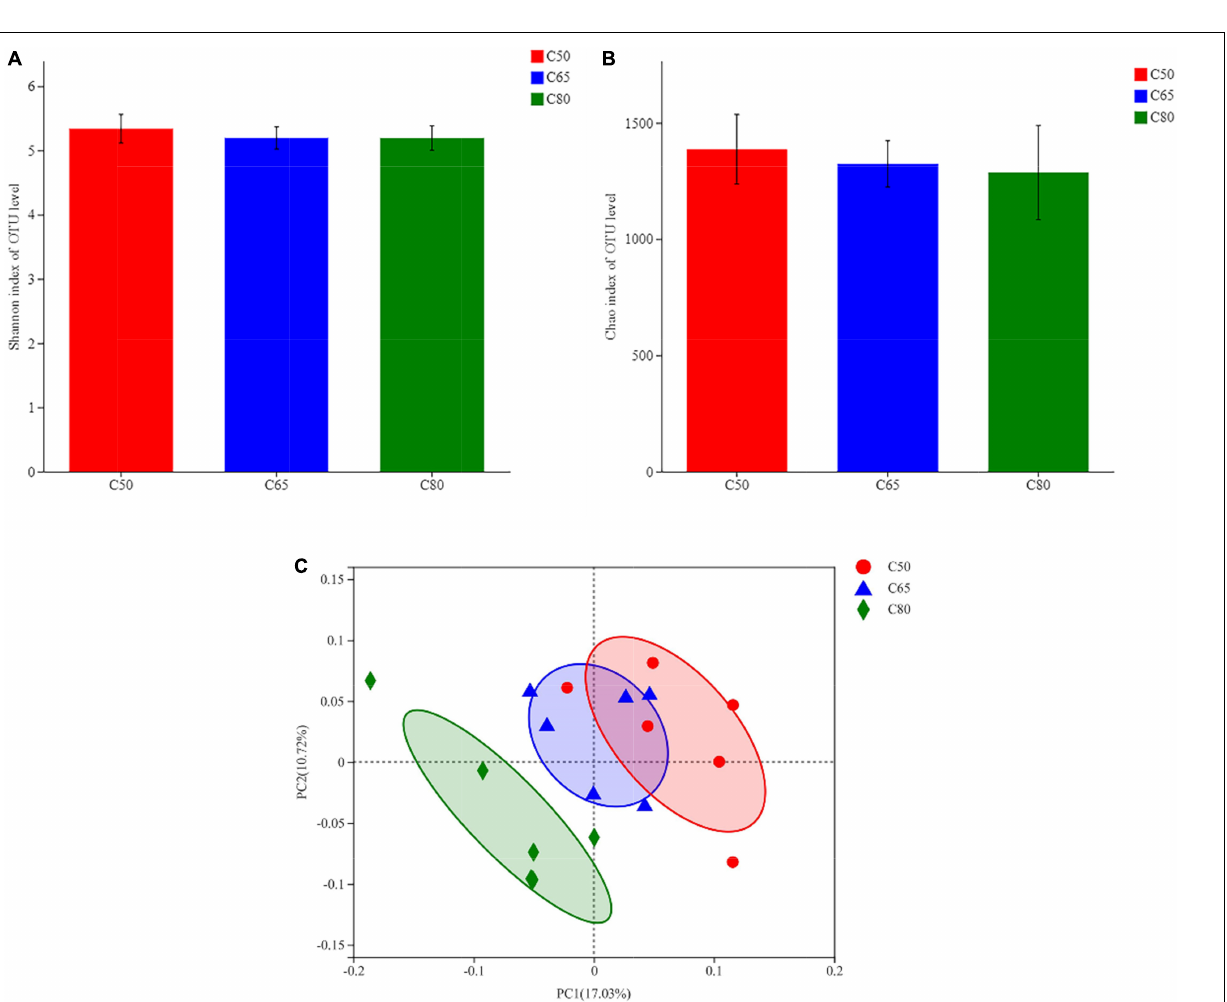
Frontiers in Nutrition |